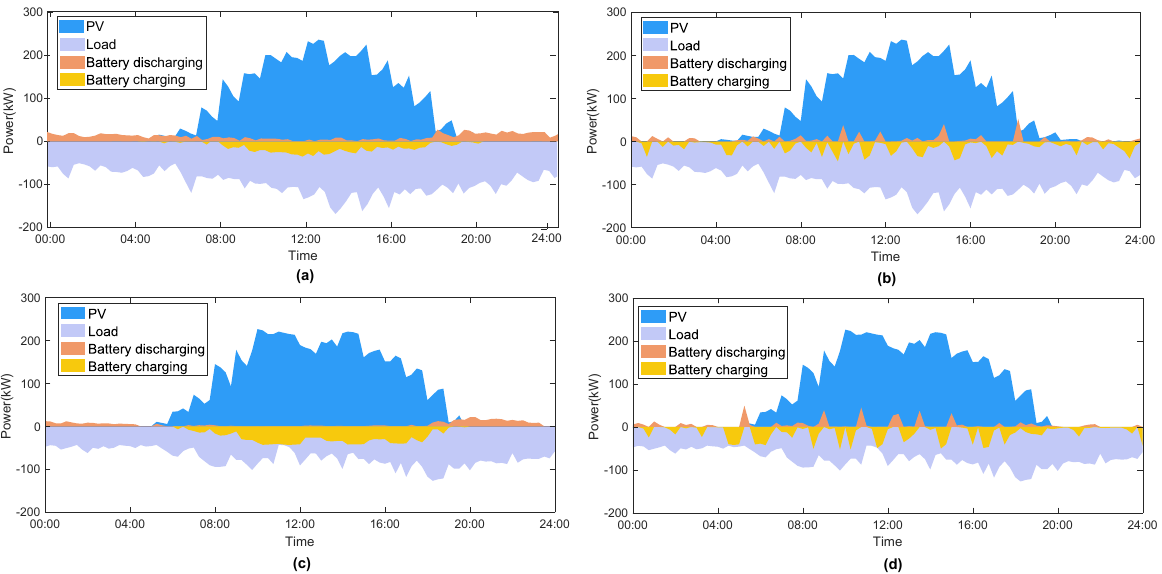
Figure 4. Detailed demand profile of the community: ( a ) weekday-SBEMS, ( b ) weekday-reference, ( c ) weekend-SBEMS, and ( d ) weekend-reference.